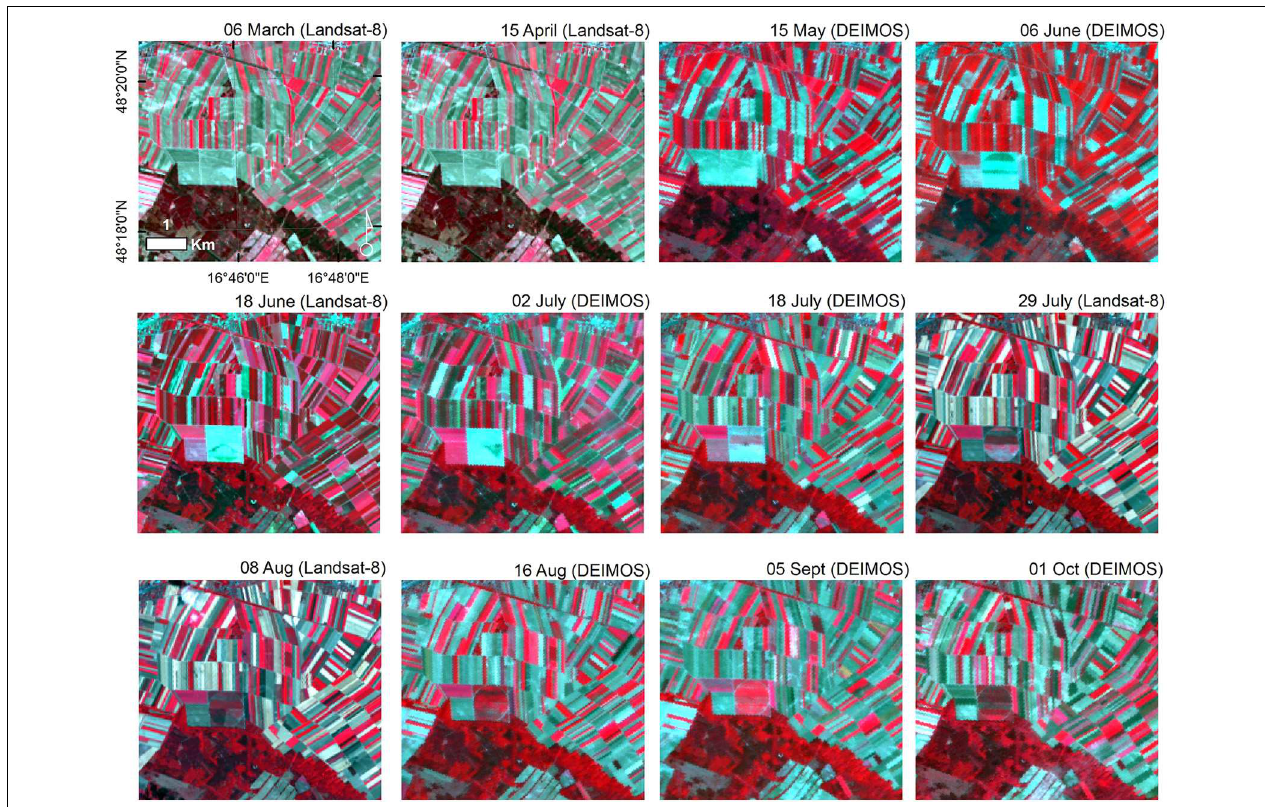
FIGURE 2 | Near-infrared color composite of a time series of DEIMOS-1 and Landsat-8 images over Marchfeld in the year 2013. Four more cloud-free Landsat-8 scenes were available on May 1st, September 6th, October 1st and